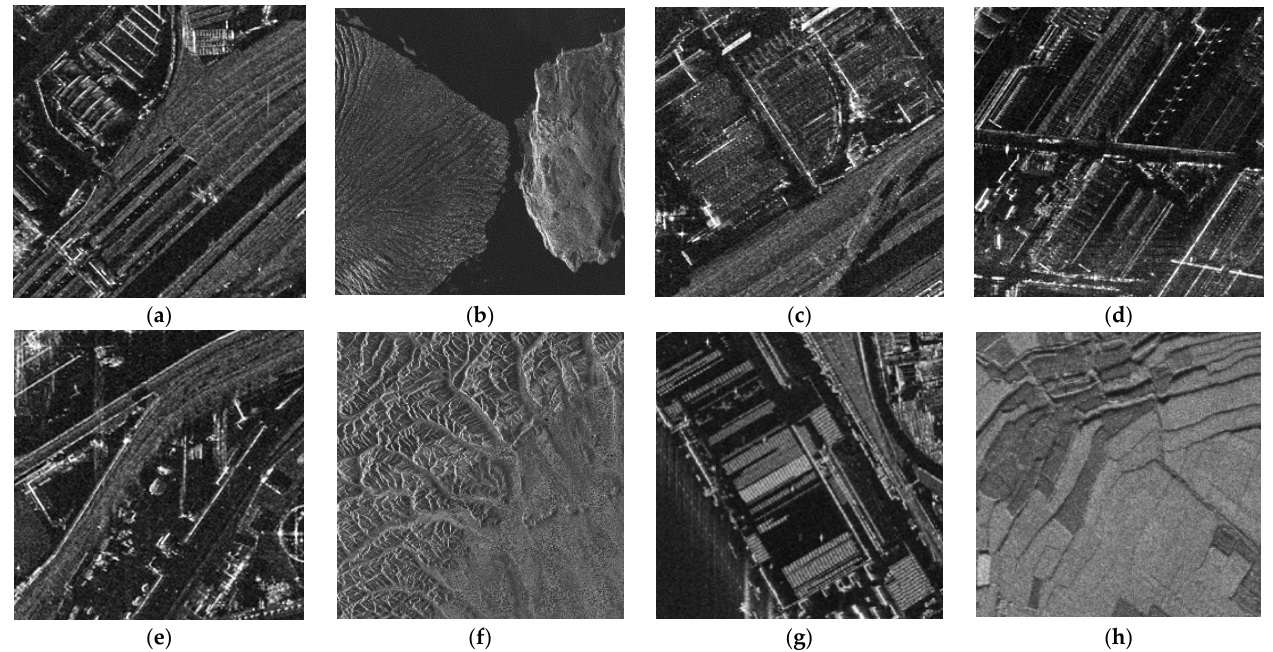
Figure 6. Test images. ( a ) Image 1; ( b ) Image 2; ( c ) Image 3; ( d ) Image 4; ( e ) Image 5; ( f ) Image 6; ( g ) Image 7; ( h ) Image 8.